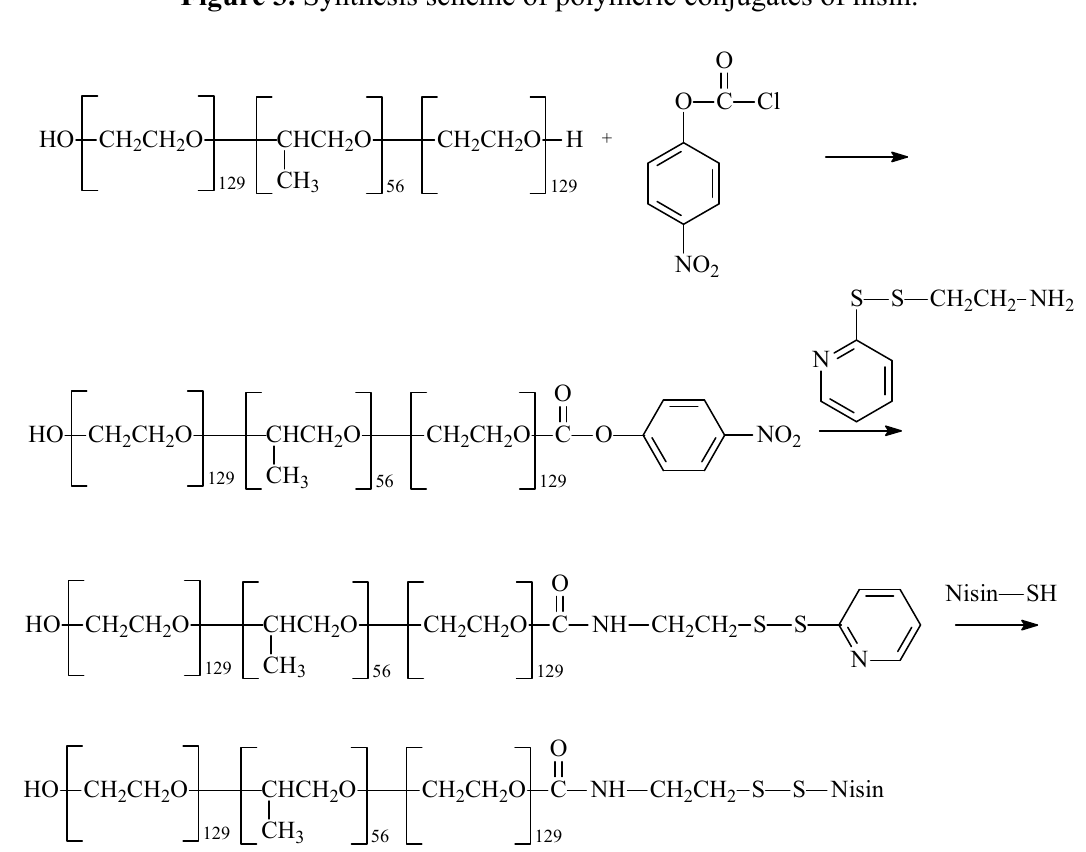
Figure 3. Synthesis scheme of polymeric conjugates of